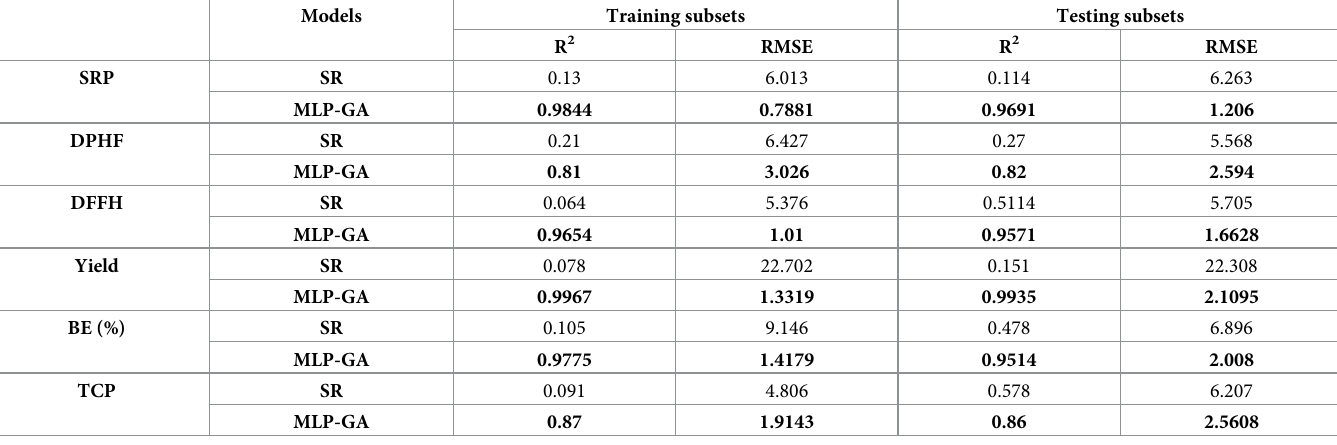
Table 4. Statistics on stepwise regression (SR) and multilayer perceptron-genetic algorithm (MLP-GA) models for yield, biological efficiency (BE), spawn run period (SRP), days for pinhead formation (DPHF), days for the first harvest (DFFH), and total cultivation period (TCP) in Auricularia cornea cultivation on differ- ent substrates obtained from different ratios of beech and hornbeam sawdust, and wheat and rice